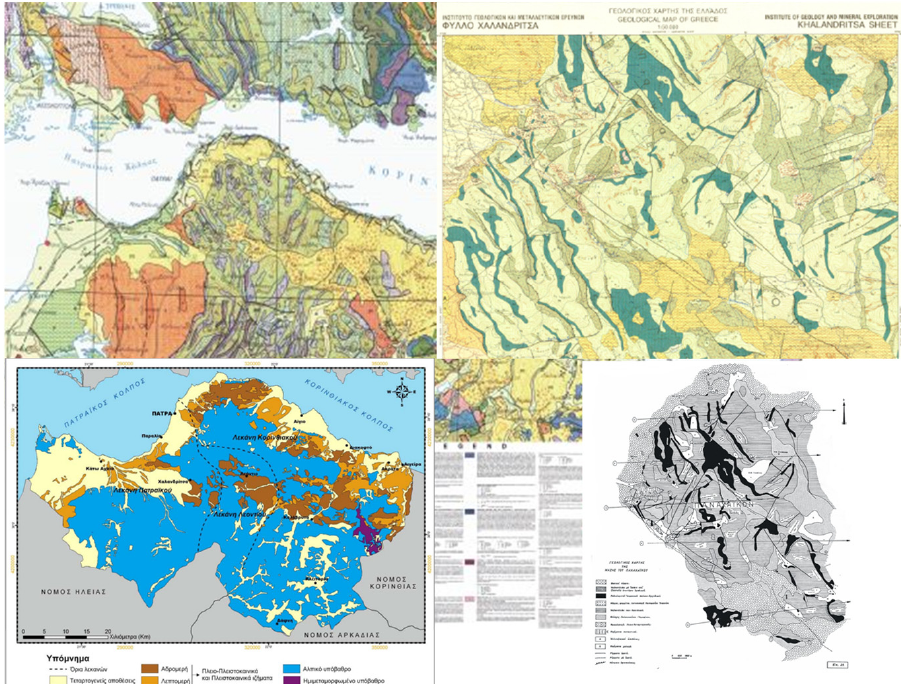
Figure 1. Different kinds of geological maps used for this study. Explanations are provided in text.